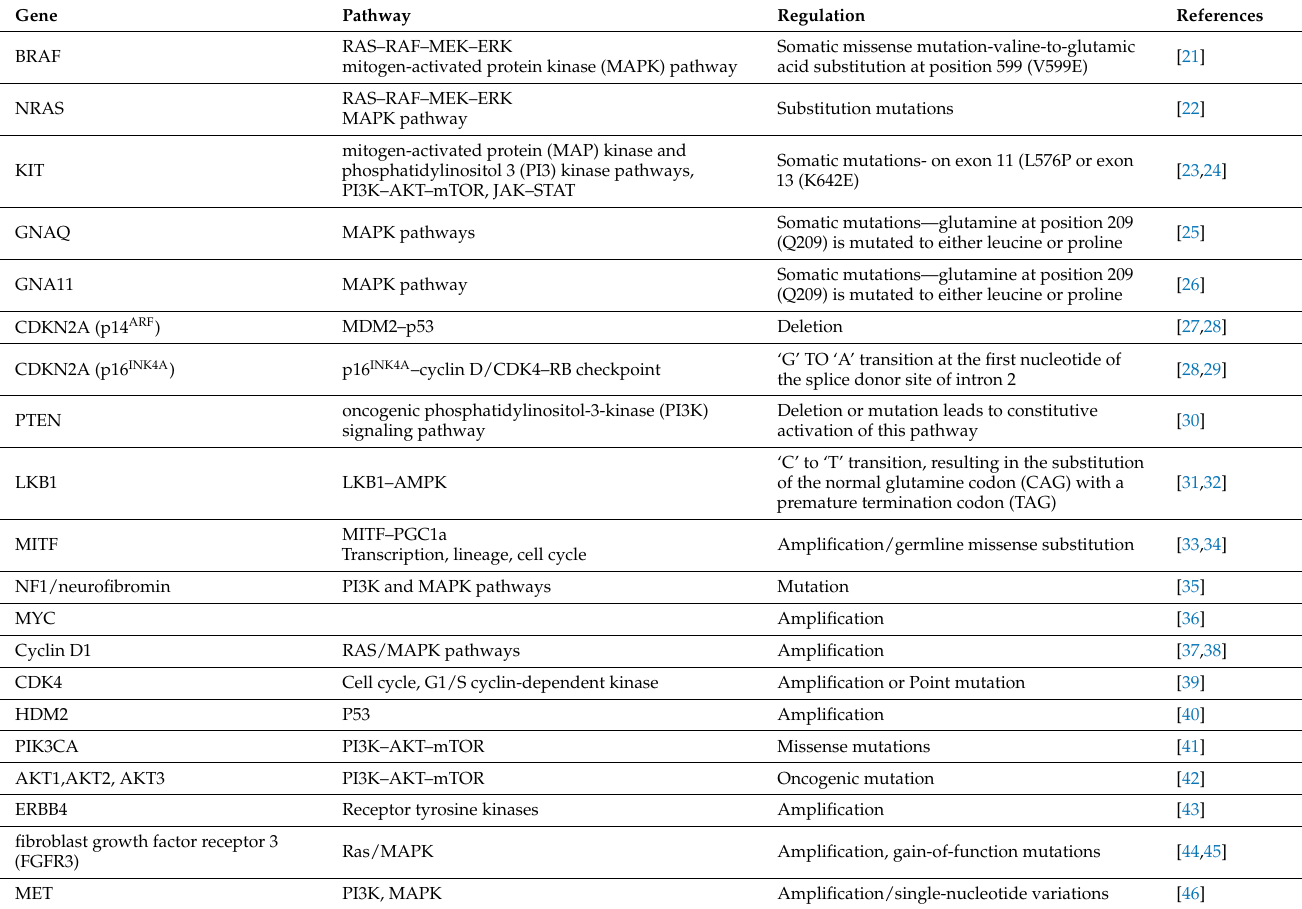
Table 1. Genes and pathways involved in